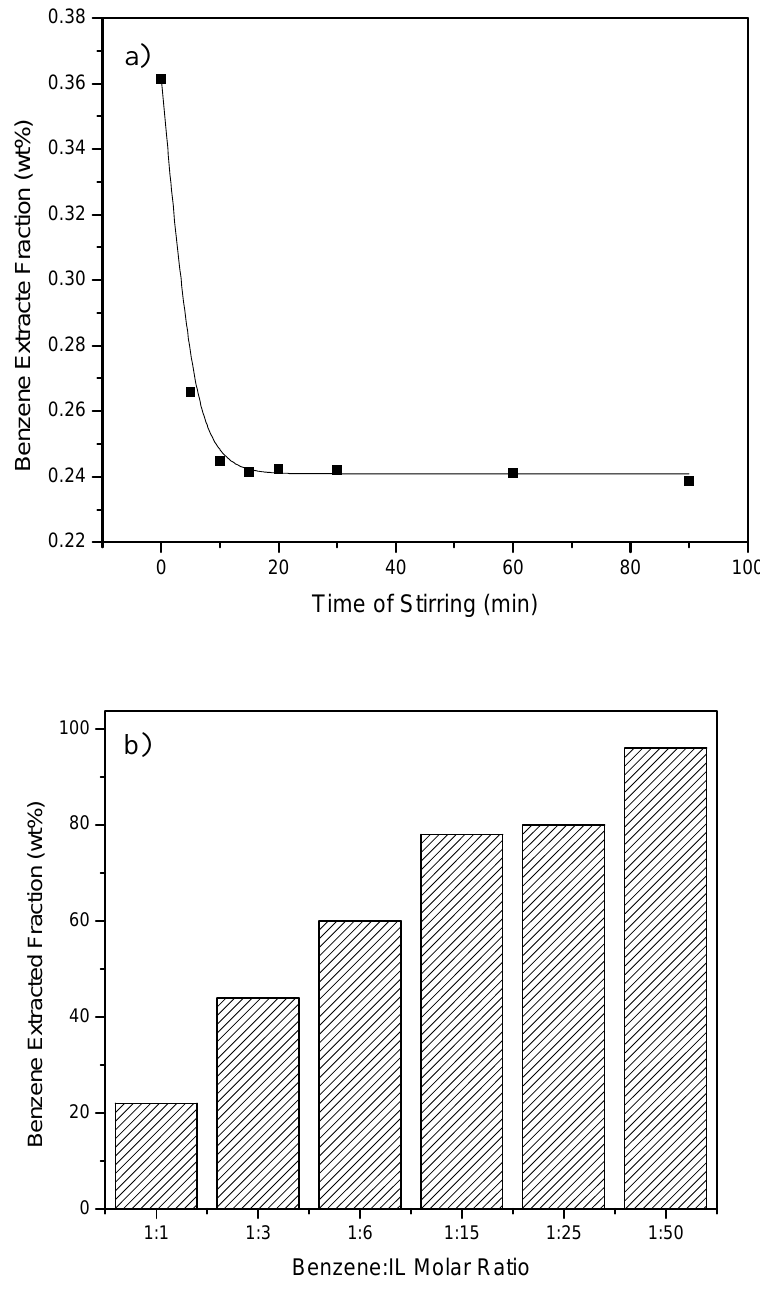
Figure 3. (a) Content of benzene in the organic phase observed after different extraction times, and (b) the extracted fraction of benzene from different ratios of benzene and BMI.N(Tf) . 2 The extraction process is also quite sensitive to stereo-electronic effects imposed by the substituents on the N -alkyl side chain of the 1-methylimidazolium cation (Figure 4). Indeed, the quantity of benzene extraction [39] increases with the increase of the numbers of the carbons of the N -alkyl side chain (from ethyl to n -decyl). However, there is also an increase on the n -octane content on the ionic liquid phase (from 1 wt % in EMI.N(Tf) to 6 wt % in DMI.N(Tf) and therefore a reduction on the extraction 2 2 benzene selectivity from the mixture [40] (from 20:1 in EMI.N(Tf) to 35:6 in DMI.N(Tf) ). 2 2